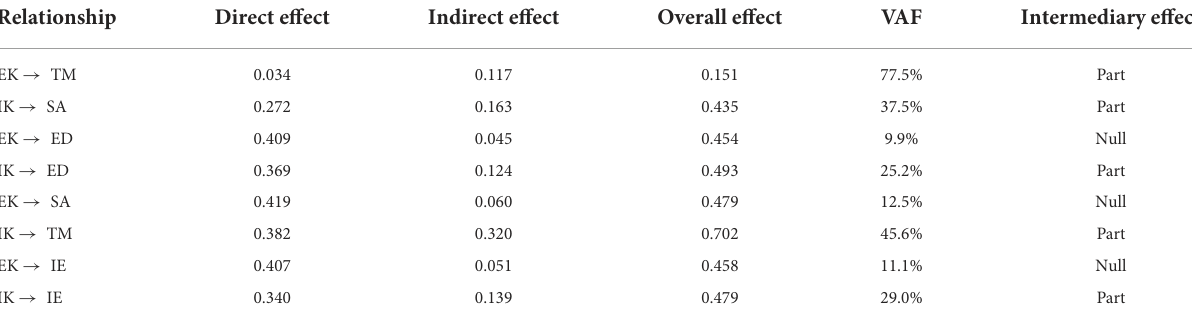
TABLE 9 Evaluation of the mediation